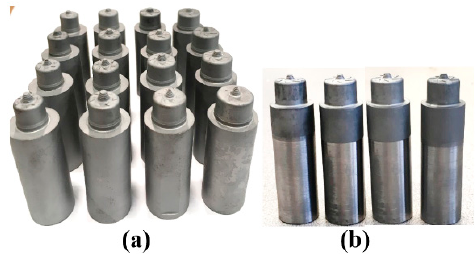
Figure 4. ( a ) 16 tools made according to the L16 design of experiments (DOE) presented in Table 2; ( b ) Four tools made regarding Table 3. Table 2. The experiments conducted according to the L16 orthogonal array. For each condition of the L16 array, tow tests were done with different tool plunge depths. Sample